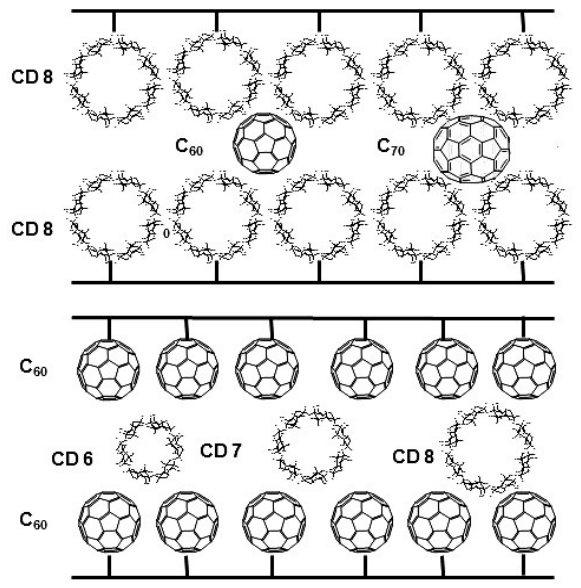
Figure 23. Schematic representation of the reciprocal principle between fullerenes and cyclodextrins.